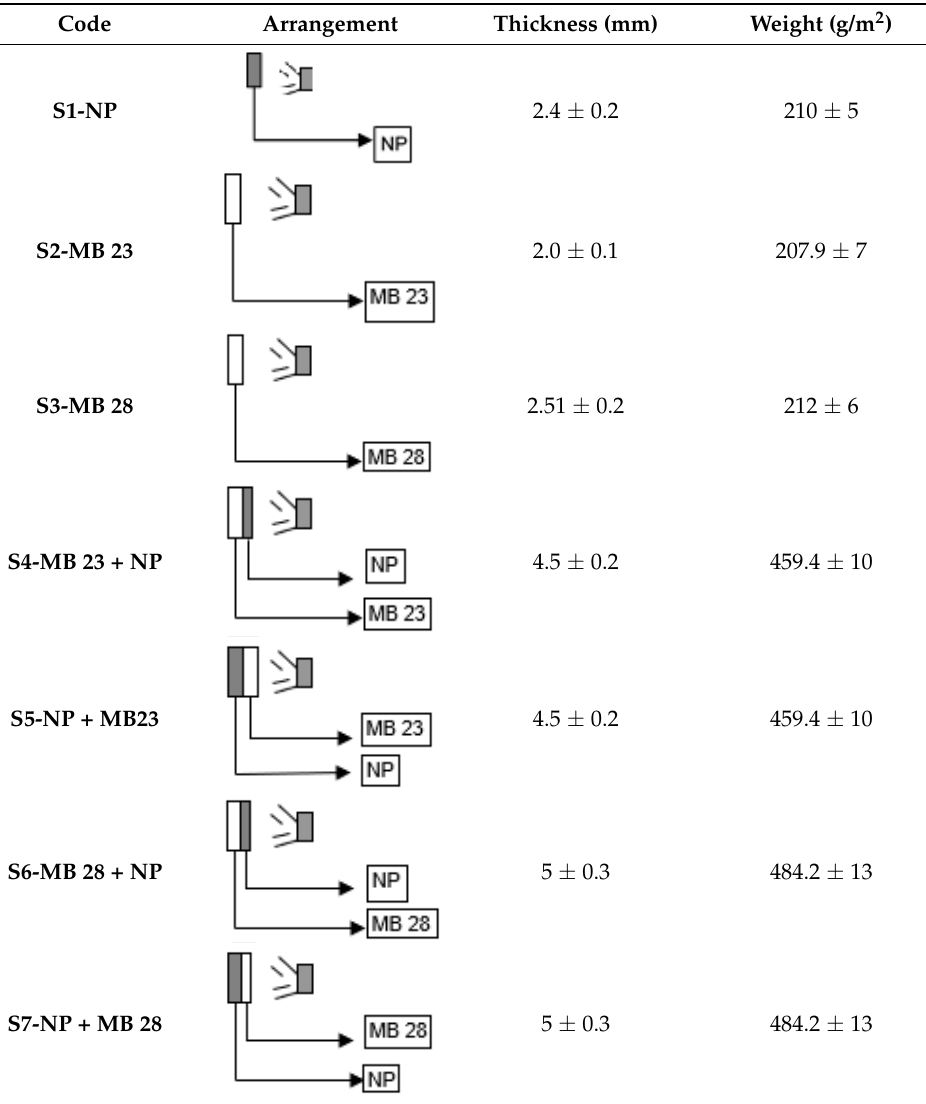
Table 3. Arrangement and technical information of samples.